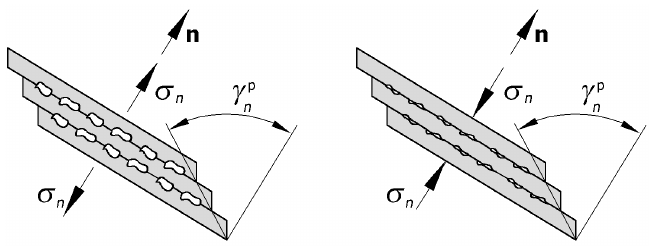
Figure 8. Generation of defects on the physical plane by slip band [22].